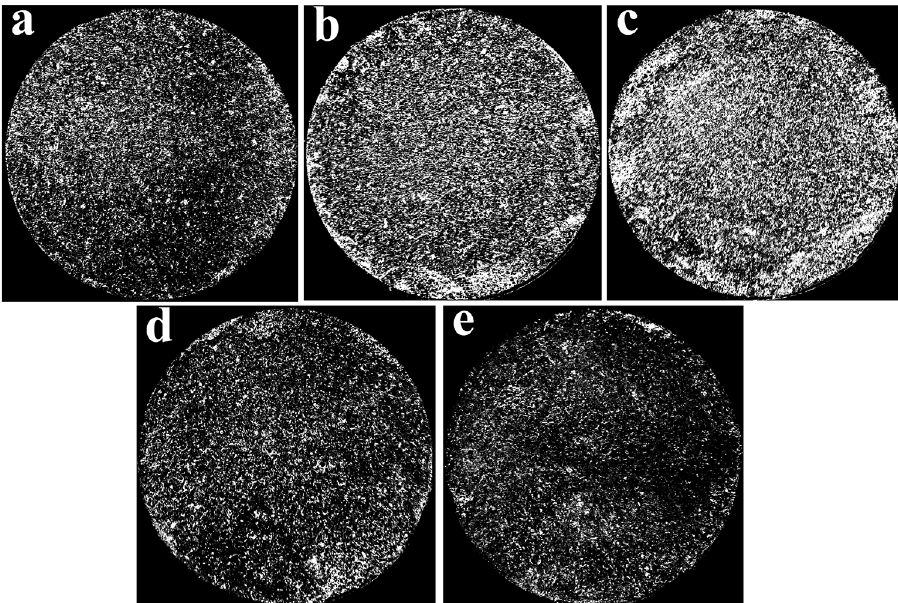
Figure 6. Binary images of soil samples affected by a single factor after 20 freeze–thaw cycles. ( a ) N = 20, 13%, 1.48 g cm −3 , (F1) ( b ) N = 20, 16%, 1.48 g cm −3 (F4), ( c ) N = 20, 19%, 1.48 g cm −3 (F7), ( d ) N = 20, 13%, 1.53 g cm −3 (F2) and ( e ) N = 20, 13%, 1.58 g cm −3 (F3).